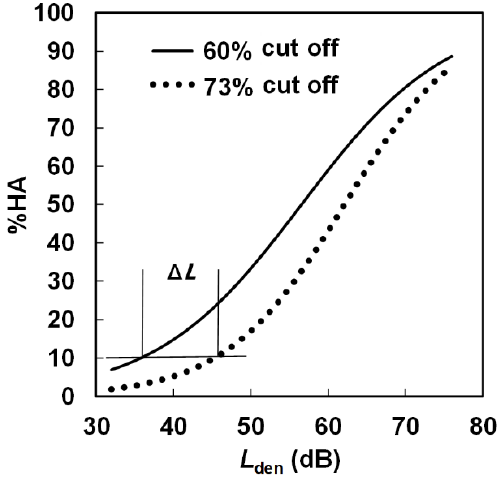
Figure 2. L den –% highly annoyed relationships for 60% and 73%